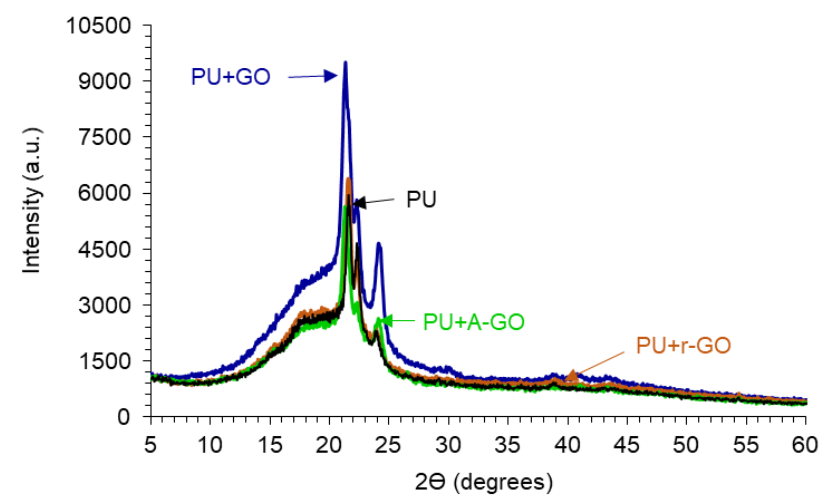
The crystallinity of the PUs is due to the interactions between the hard and the soft segments, as assessed by X-ray diffraction. Figure 12 shows the X-ray diffractograms of the PUs in which three diffraction peaks at 2Ө values of 21.30– 21.65, 22.20 – 22.35, and 23.75 – 24.10° can be distinguished, they are somewhat similar irrespective of the functional groups on the GO derivatives. T he diffraction peaks at 2Ө values of 18.3– 20.75° of the GO derivatives do not appear in the X-ray diffractograms of the PUs because of its adequate